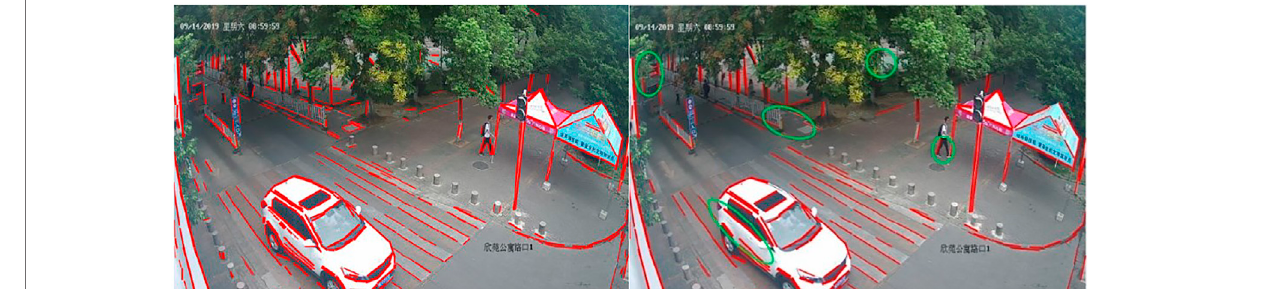
Number of lines after fi ltering